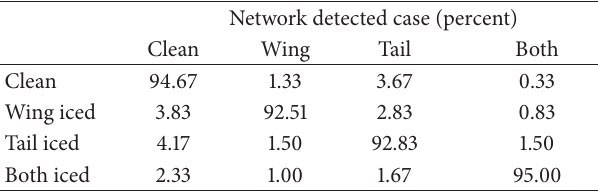
Table 2: Detected result for each (actual) icing case.